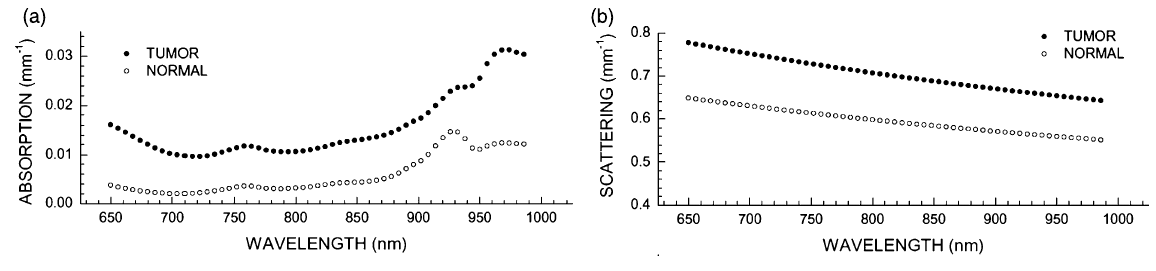
Fig. 2. Absorption (a) and scattering (b) spectrum of tumor vs. normal breast tissue (after [7]).